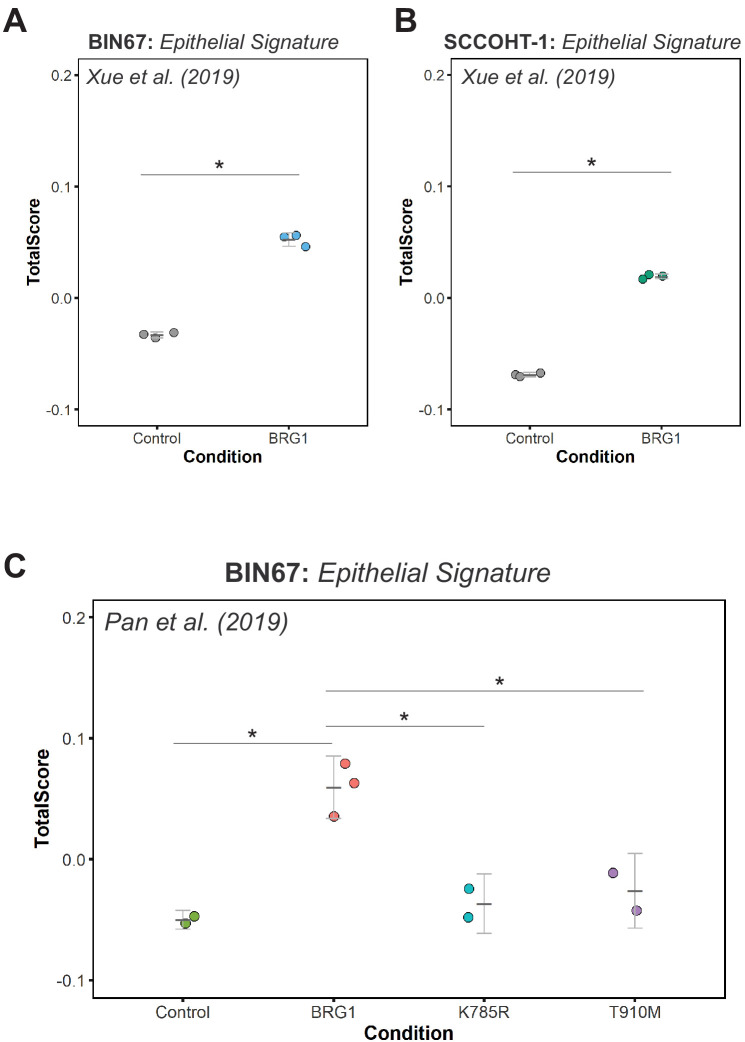
Epithelial signature scoring in previously published SCCOHT datasets.Scoring of epithelial signature in RNA-seq data using singscore for: (A) BIN67 +/- BRG1; Xue et al., 2019b, (*Welsh Two Sample t-test p-value=0.00028) (B) SCCOHT-1 +/- BRG1; Xue et al., 2019b, (*Welsh Two-Sample t-test p-value=4.367 e-07) and (C) BIN67 +/- BRG1/K785R/T910M; Pan et al., 2019 (Welsh Two-Sample t-test p-values: Control compared to wild-type BRG1 (p-value=0.0097)), BRG1 wildtype to K785R mutant (p-value=0.0162) and BRG1 wild-type to T910M mutant (p-value=0.0405).